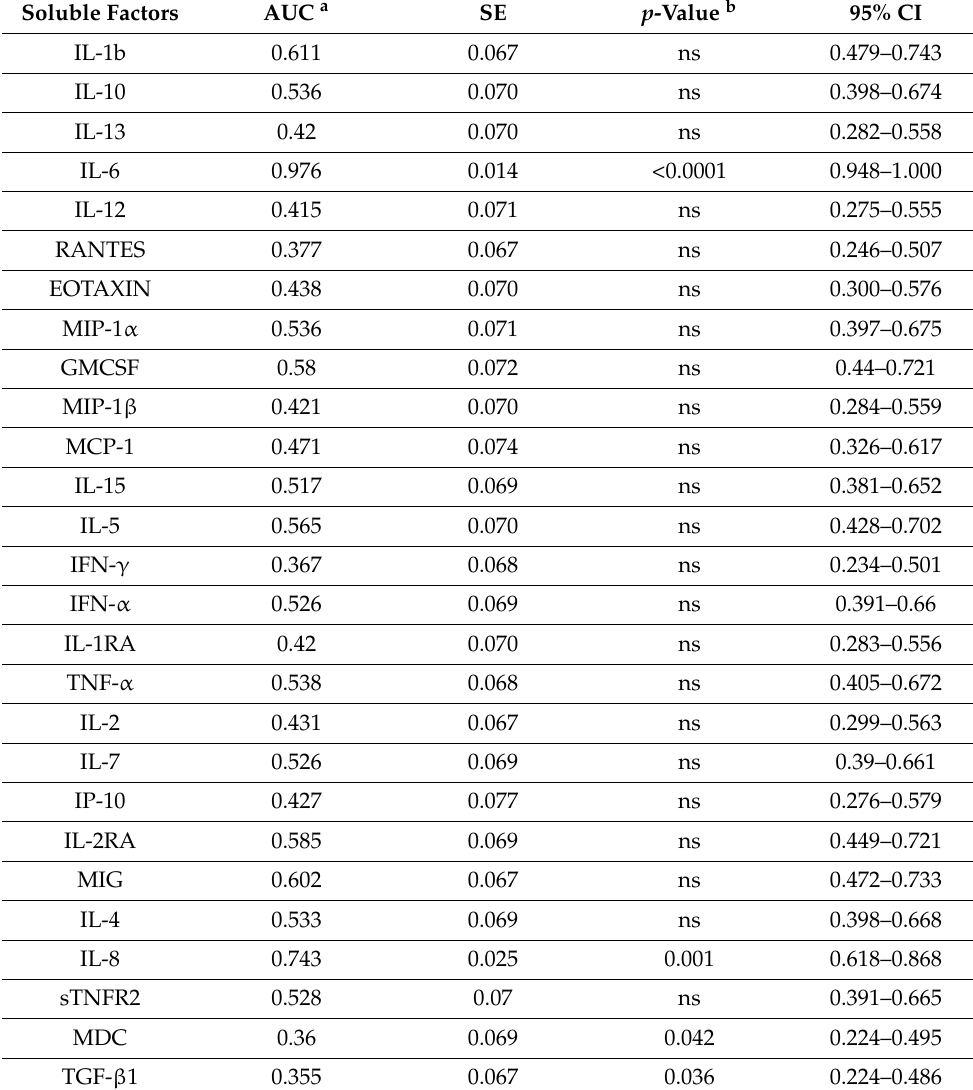
Table 4. Comparison of ROC-AUC values of pre-treatment soluble factor concentration for patients with malignant and non-malignant ovarian